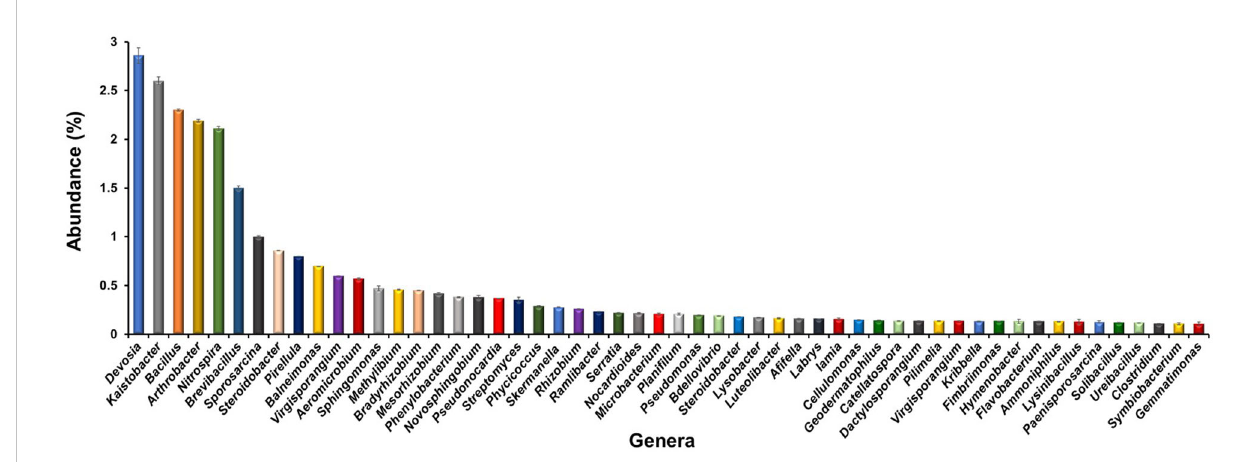
FIGURE 3 Bacterial genera observed in the rhizosphere of L. camara L. Genera with ≥ 0.1% abundance have been listed